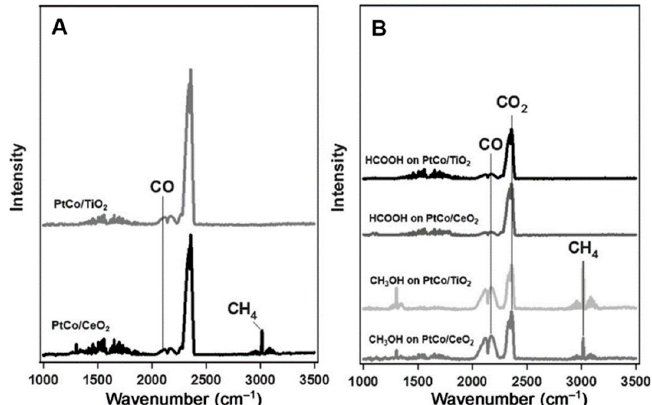
Figure 11. FTIR spectra recorded during ( A ) CO 2 reduction in the presence of H 2 and ( B ) the reactions of formic acid and methanol over PtCo/CeO 2 and PtCo/TiO 2 catalysts. Reprinted with permission from Reference [60]. Copyright 2016, John Wiley and Sons.